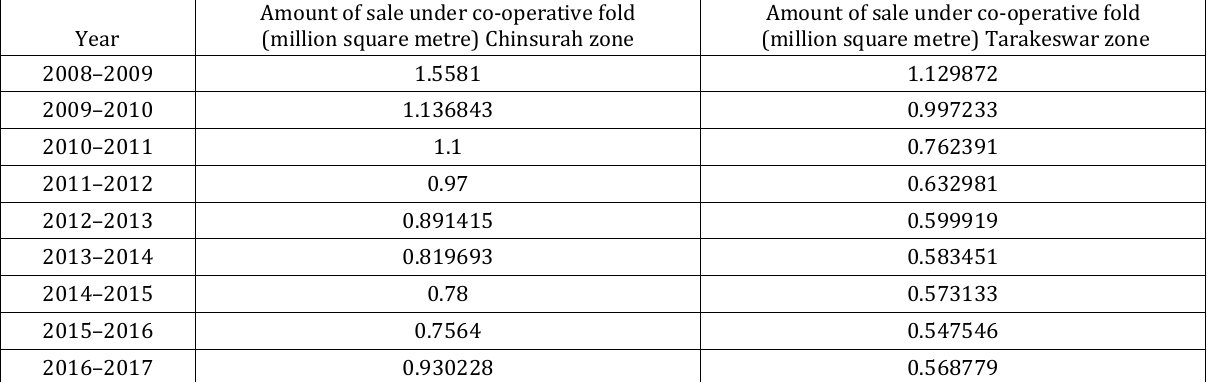
Amount of sale under co-operative fold (million square metre) Tarakeswar